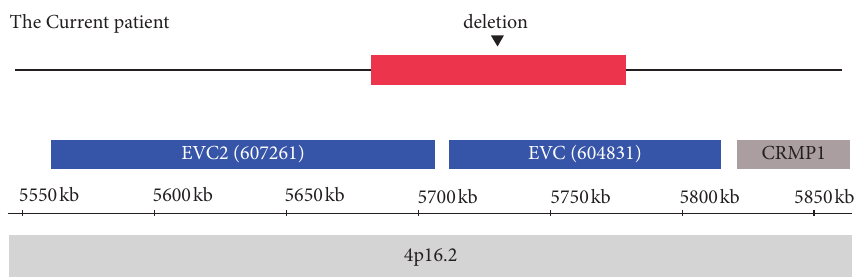
Figure 2: The result of CMA revealed an approximately 97 kb microdeletion at 4p16.2 (5,683,080–5,780,476), which included part of EVC and EVC2 genes. Table 1: Clinical features of EvC, WAD, and the current